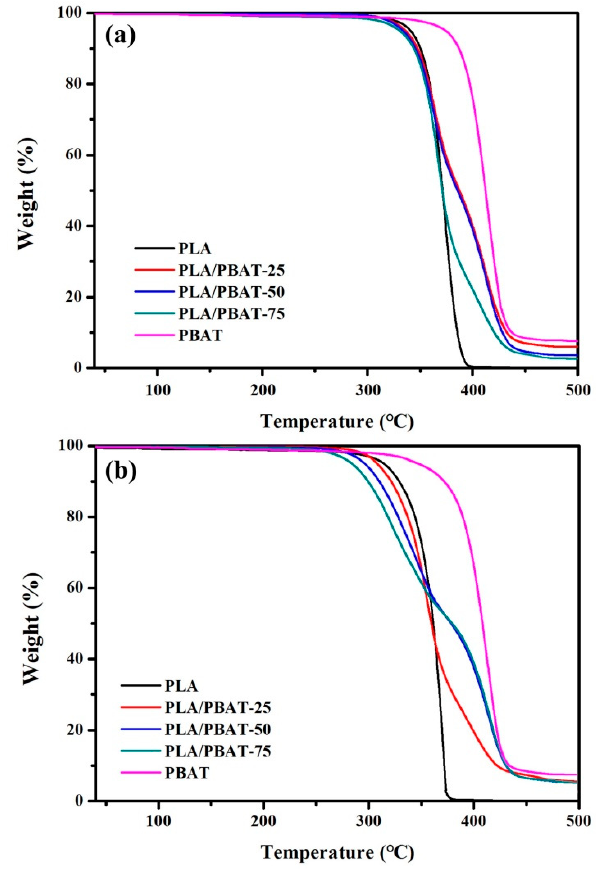
Figure 3. TG curves of PLA / PBAT composite films ( a ) before and ( b ) after 24 months of degradation.